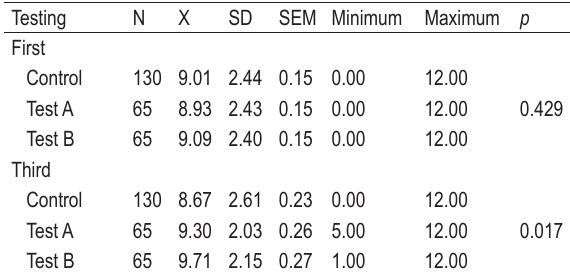
TABLE 5. Comparison of gait values during the first and third measurements